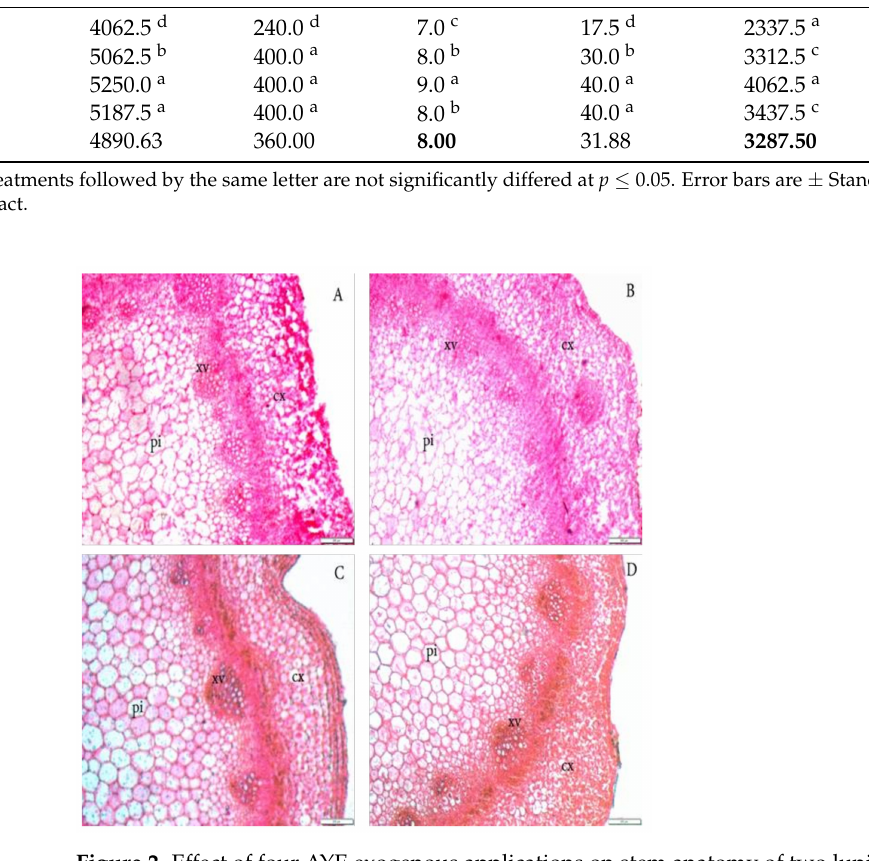
Figure 2. Effect of four AYE exogenous applications on stem anatomy of two lupine cultivars grown in reclaimed-saline soil. ( A ) = Control (Giza 1); ( B ) = Control (Giza 2); ( C ) = 75 mL AYE L − 1 (Giza 1); ( D ) = 75 mL AYE L − 1 (Giza 2); cx = cortex; xv = xylem vessel; Pi = Pith; Scale bar = 200 µ